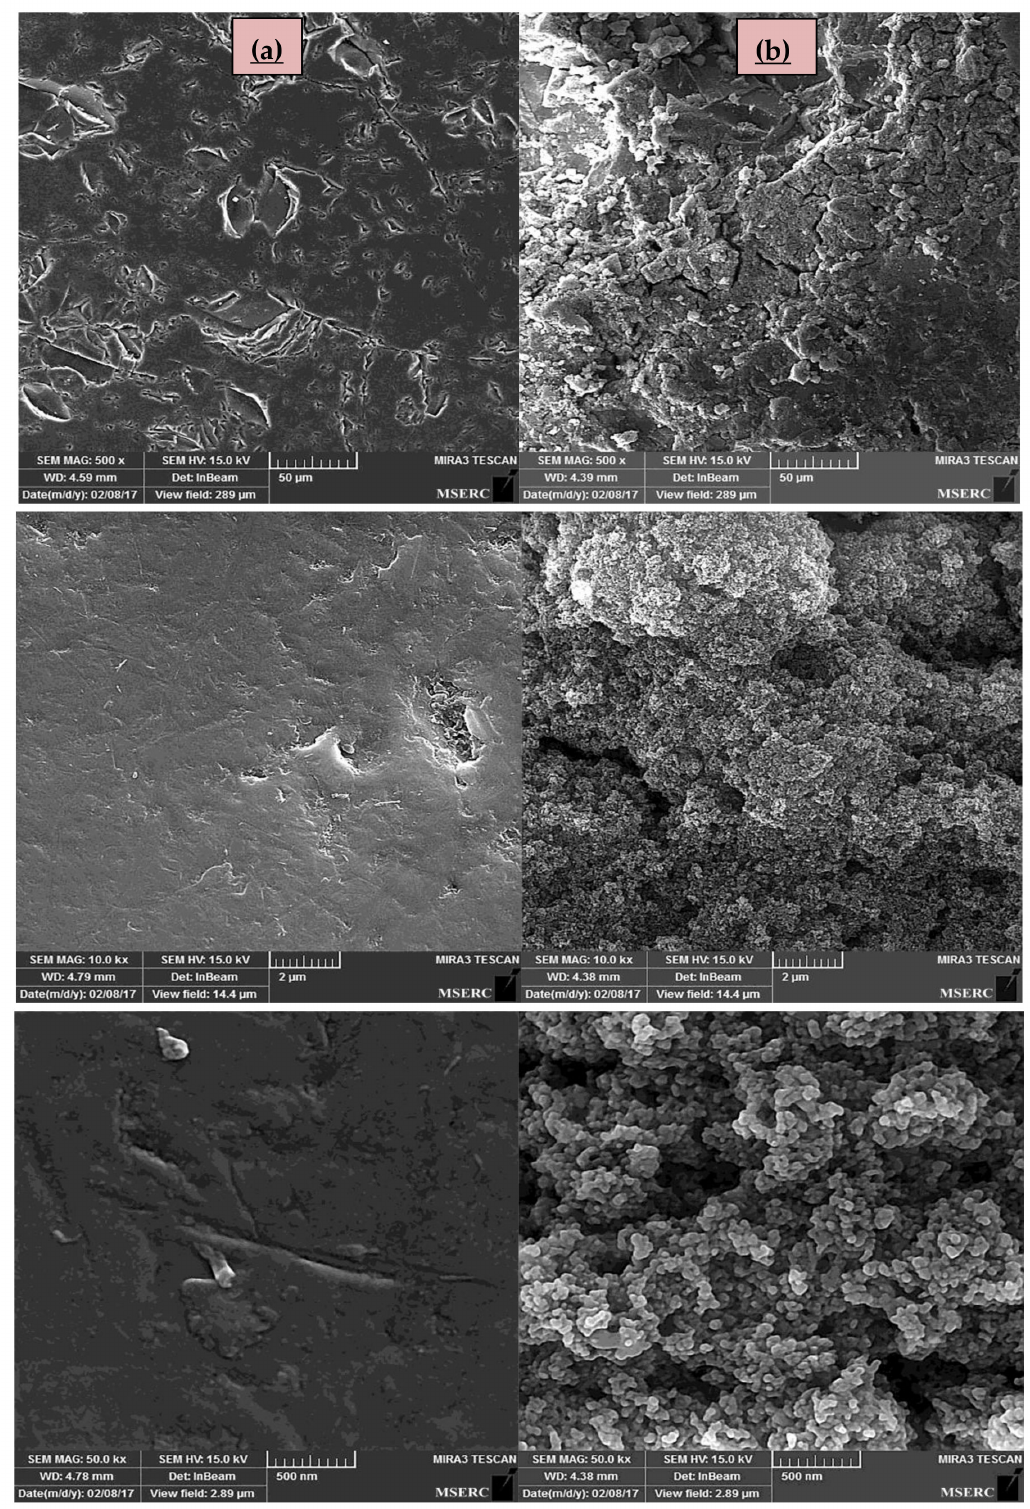
Figure 5. SEM images of the surface of ( a ) uncoated glass beads; ( b ) the glass beads coated by N-doped TiO 2 catalyst in different